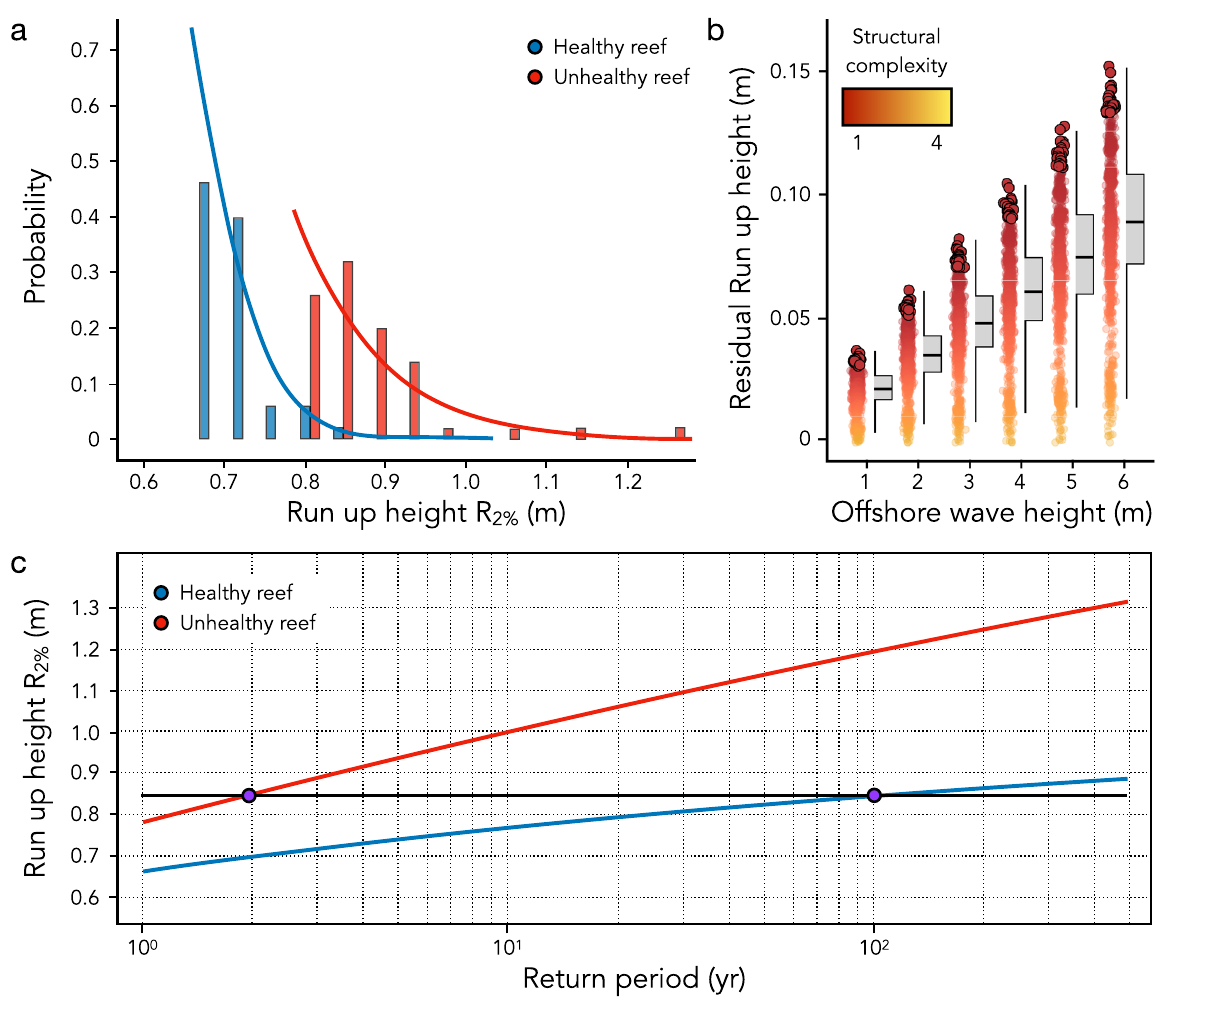
Figure 5. ( a ) Comparisons of the 2% exceedance wave run-up height under healthy (blue) and unhealthy (red) coral reefs conditions. For each case, we superimpose the fitted Generalized Pareto Distribution (lines) on the empirical probability density function (histograms). ( b ) Residual run-up height according to the structural complexity loss and the magnitude of the event. The black-circled points highlight the 2% exceedance wave run-up height. ( c ) Extreme 2% exceedance wave run-up height (R 2% ) under healthy (blue) and unhealthy (red) coral reefs conditions. The curves show how R 2% varies with the return period, while the black horizontal line highlights that the one in a 100-year R 2% under healthy coral reef conditions (onshore wave run-up of 0.85 m) will occur at least every two years if coral reefs